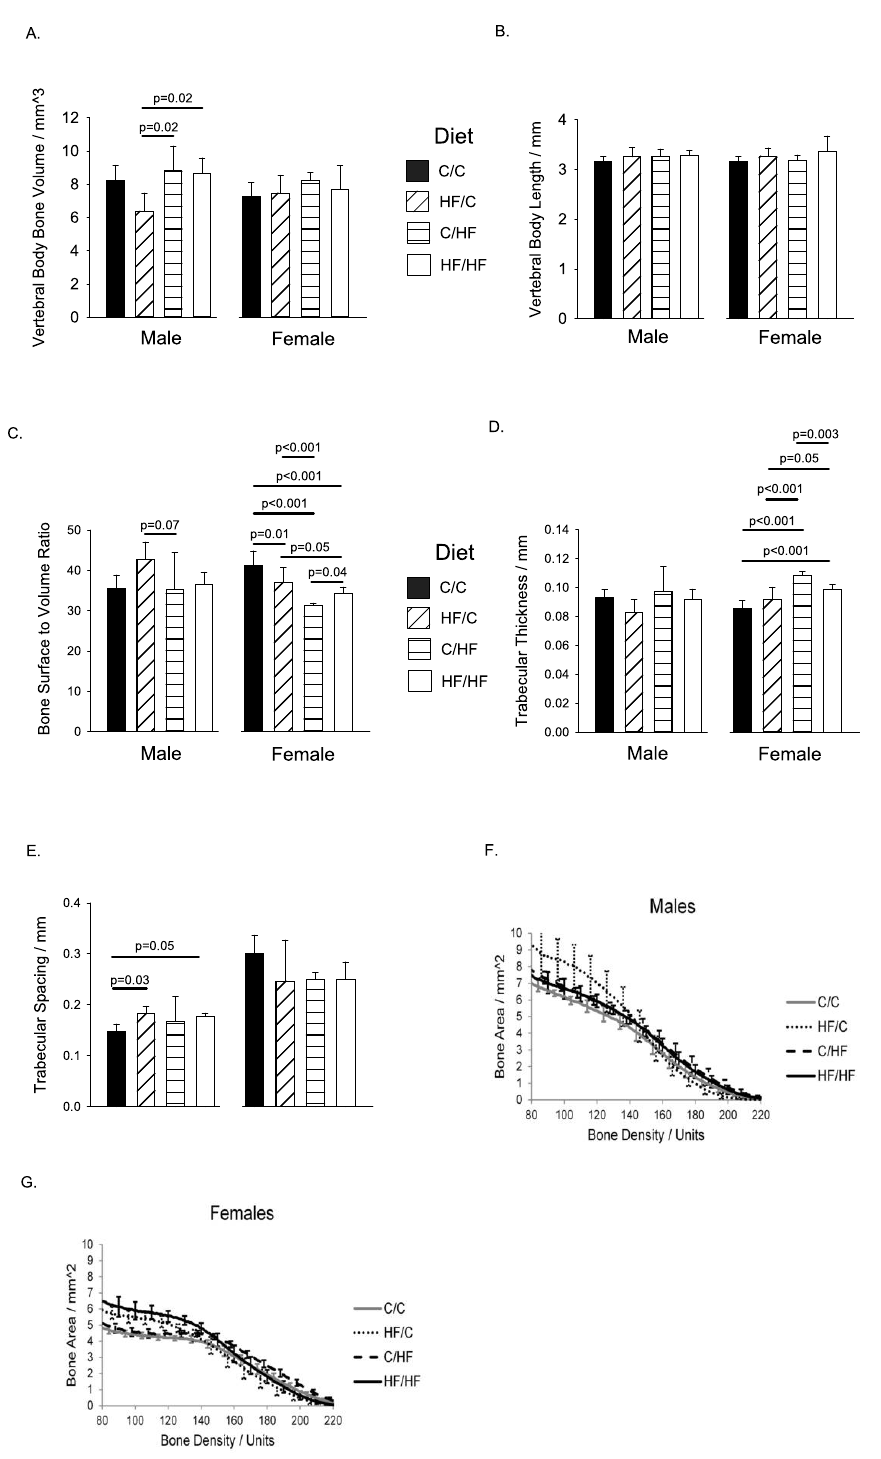
Fig 3. Vertebral Body Bone Structure at Thirty Weeks of Age. For dietary group and sex, results are shown for (A). Vertebral body bone volume. (B). Vertebral body length. (C). Bone surface to volume ratio. (D). Trabecular thickness. (E). Trabecular spacing. (F). Male whole vertebra bone density. (G). Female whole vertebra bone density. For density graphs, the bone density range 80 – 140 represents trabecular bone, and 140 – 220 represents cortical bone. For all groups, n = 5 – 7 per group. Graphs show mean plus 95% confidence limits.